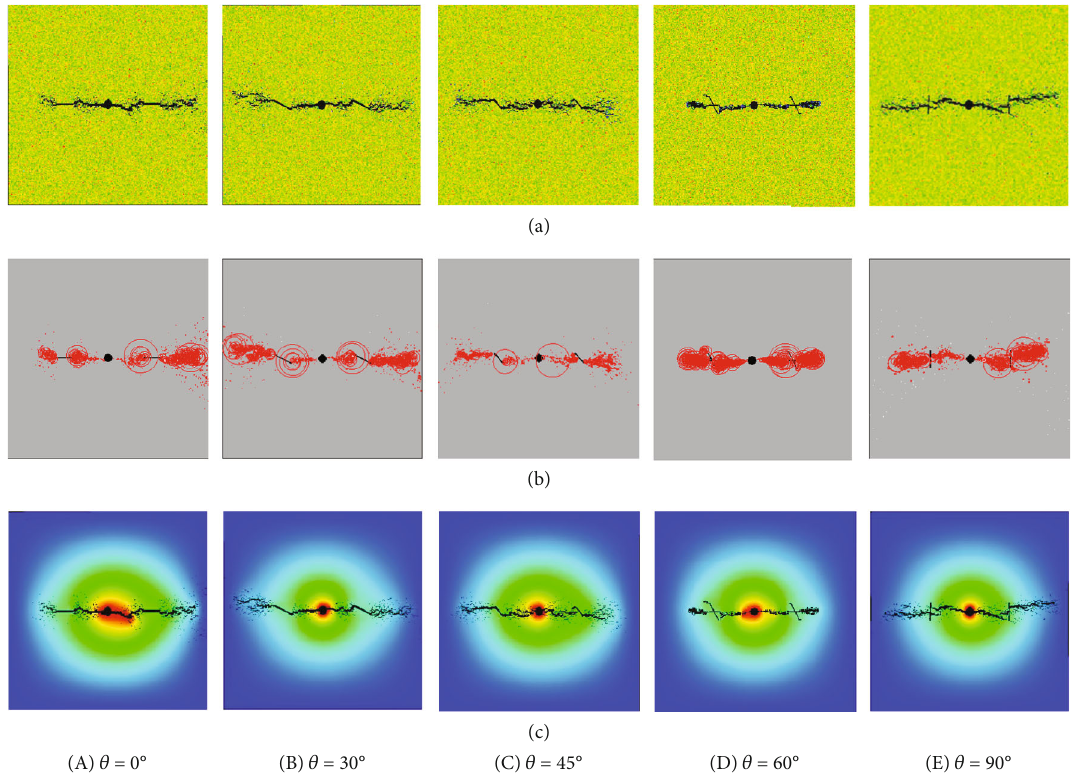
Figure 6: Process of hydraulic fracture propagation under di ff erent approach angles. (a) Morphology of hydraulic fracture propagation. (b) Acoustic emission signal. (c) Cloud map of pore water pressure.